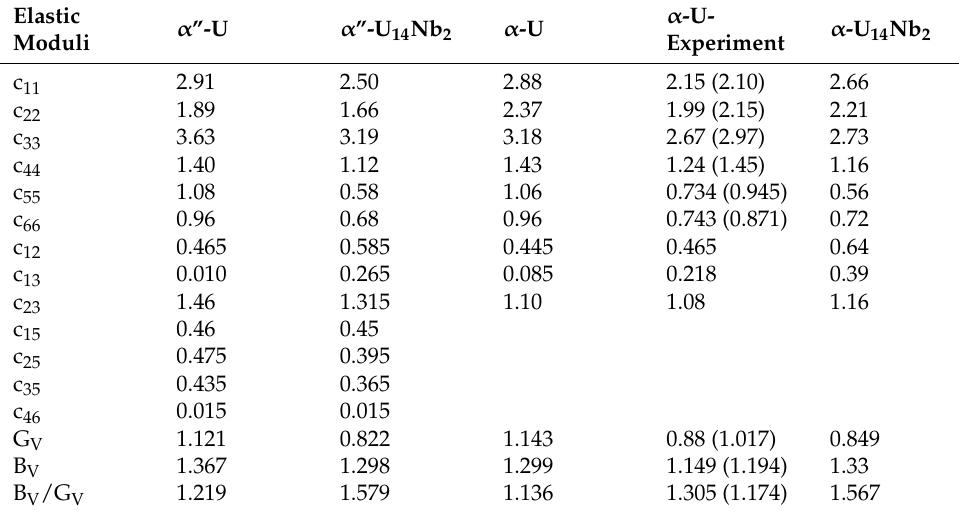
Table 1. The independent elastic moduli (Mbar) for the α ” and α phases of uranium and uranium– niobium alloy. G V and B V are the corresponding shear- and bulk-modulus Voigt averages. The quotient B V /G V (Pugh ratio) relates to malleability or ductility (high value) or brittleness (low value) [42]. For α -U, experimental data [52] shown in parentheses are extrapolations to zero temperature. Note, α ” and α are hypothetical phases for uranium and uranium–niobium alloy, respectively, shown here for